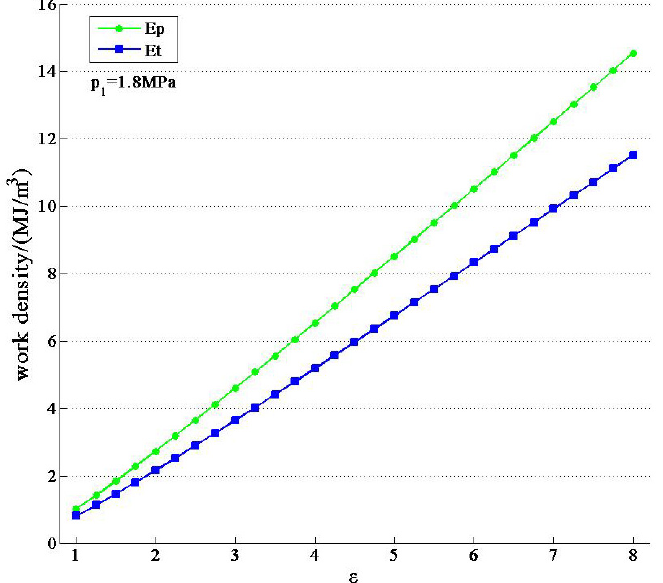
Figure 7. Work density various with water-air volume